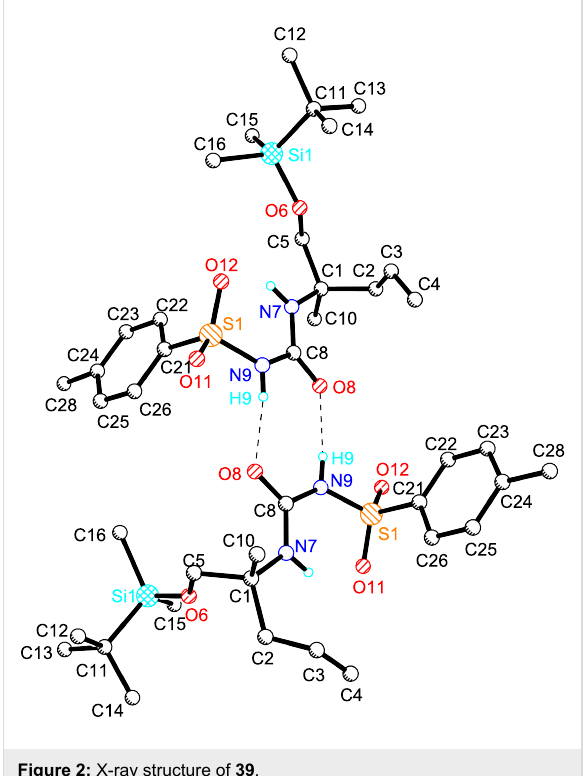
Figure 2: X-ray structure of 39